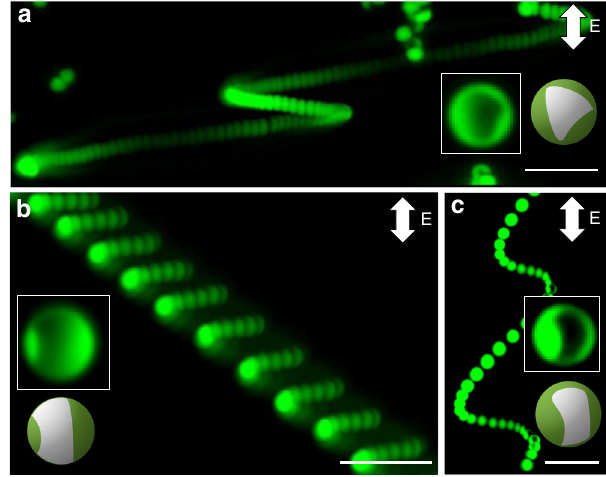
Fig. 5 Role of patch shape in directing particle trajectory. a – c Superimposed fl uorescent images of particles performing motion along non-cylindrical helical trajectories in applied electric fi eld (Supplementary Movie 4). The insets are the fl uorescent micrographs and schematics of the particles showing asymmetric metal-patch shapes (dark regions). The experiments were performed in AC-electric fi eld of strength 250 V cm − 1 and frequency 10 kHz. The unusual particle trajectories derive from the low-symmetry metal-patches shown in the insets. Scale bars in a – c are 25 µ